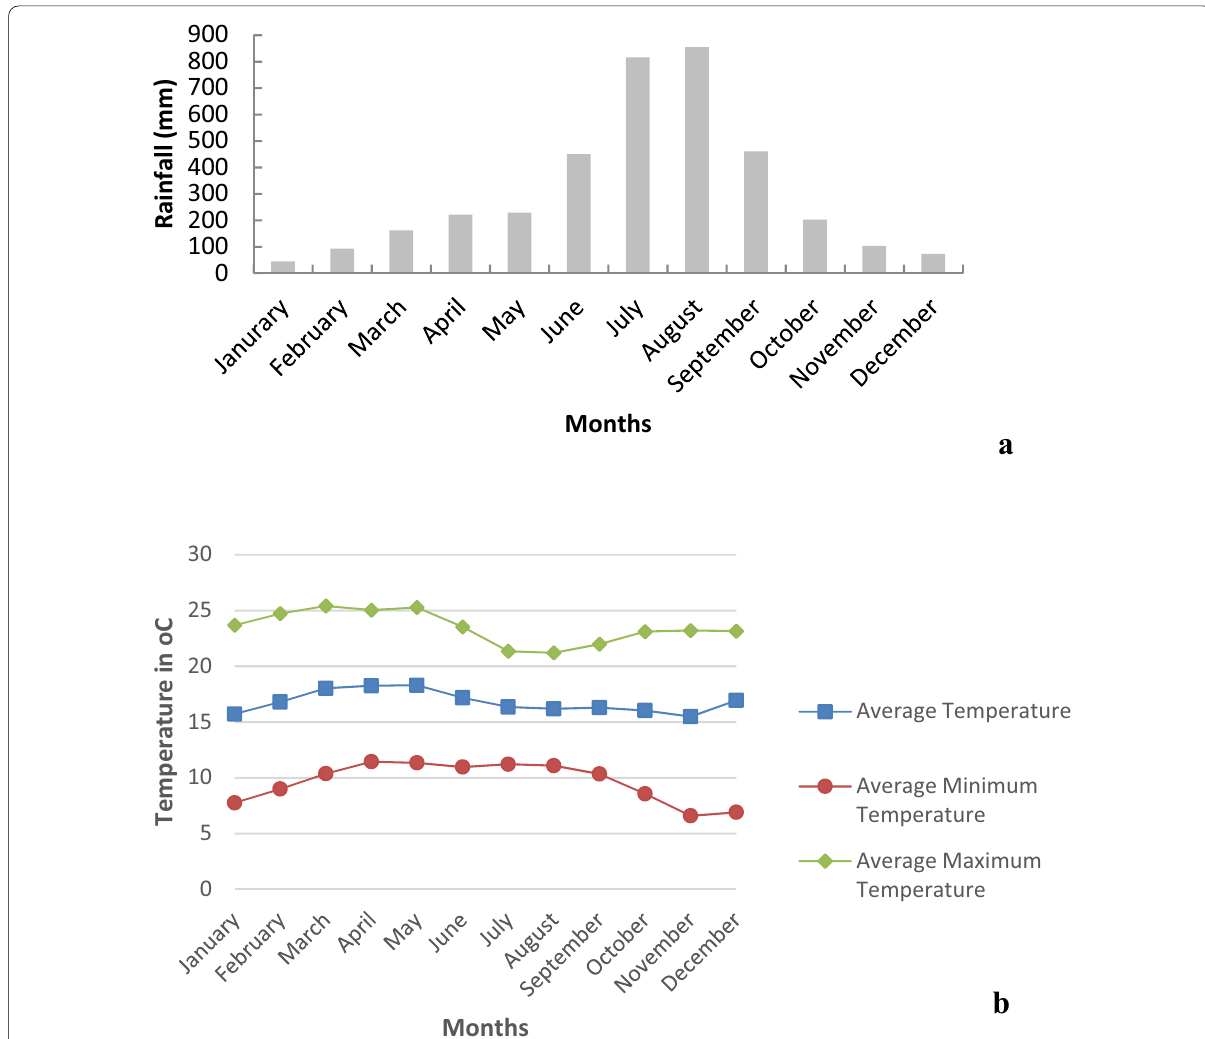
Fig. 2 Mean annual rainfall ( a ) and temperature distribution ( b ) in the city of Addis Ababa (averaged from 30 years data